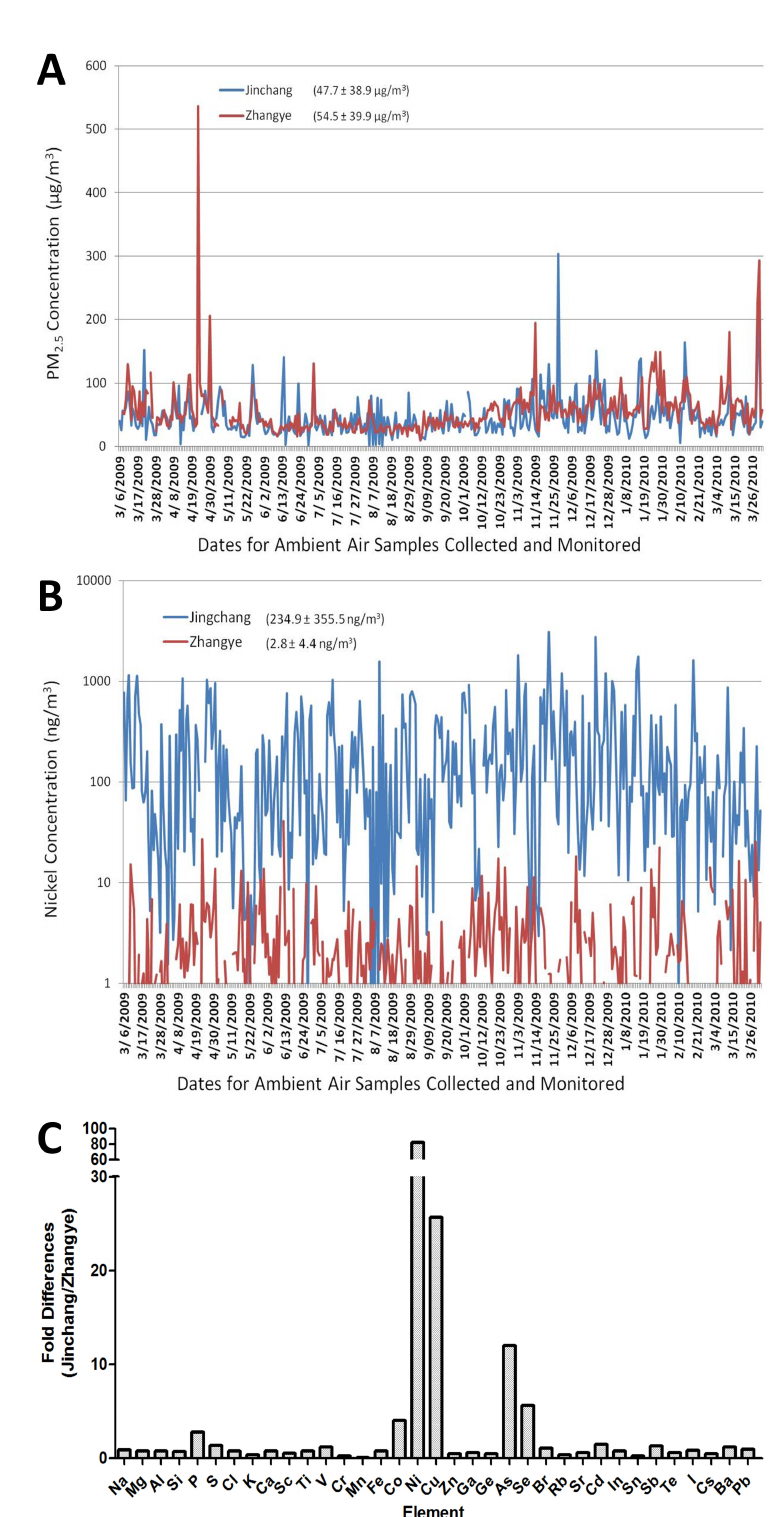
Figure 1. Differences in daily ambient exposures between Jinchang and Zhangye from March 6 th to April 4 th , 2010. Panel A: PM Mass Concentrations; Panel B: Nickel Mass Concentrations; Panel C: Fold differences in concentrations of 35 elements 2.5 between Jinchang over Zhangye. doi: 10.1371/journal.pone.0083782.g001 PLOS ONE |